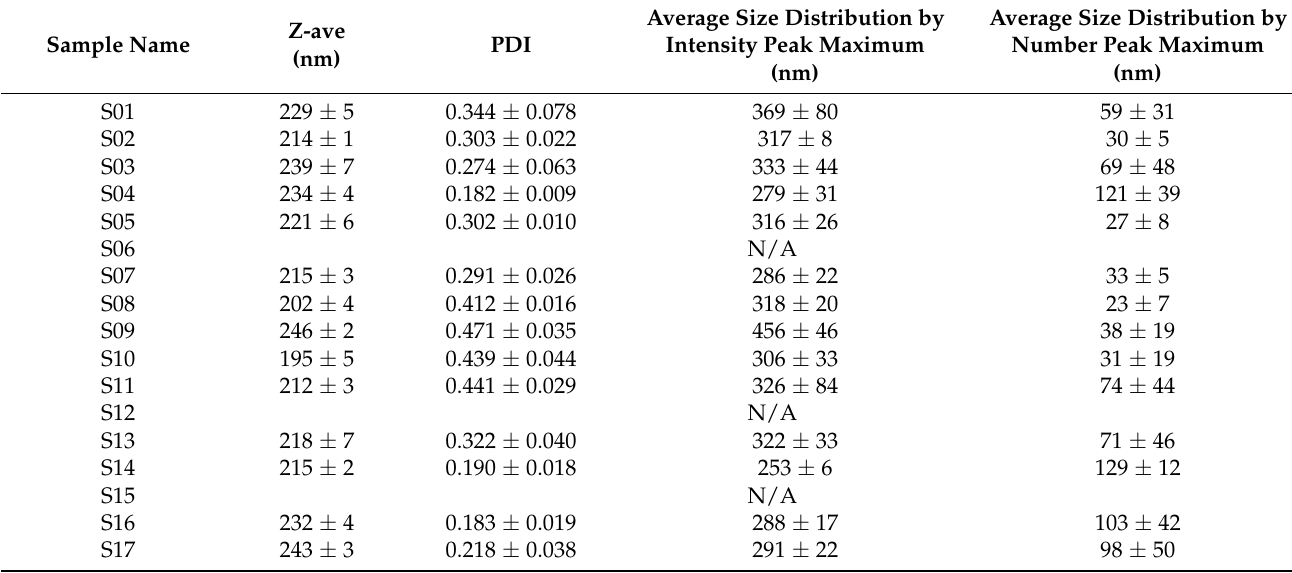
Table 3. Preliminary tests, droplet size distribution results: Z-ave (nm); PDI—polydisperisty index; average size distribution by intensity peak maximum (nm) and average size distribution by number peak maximum